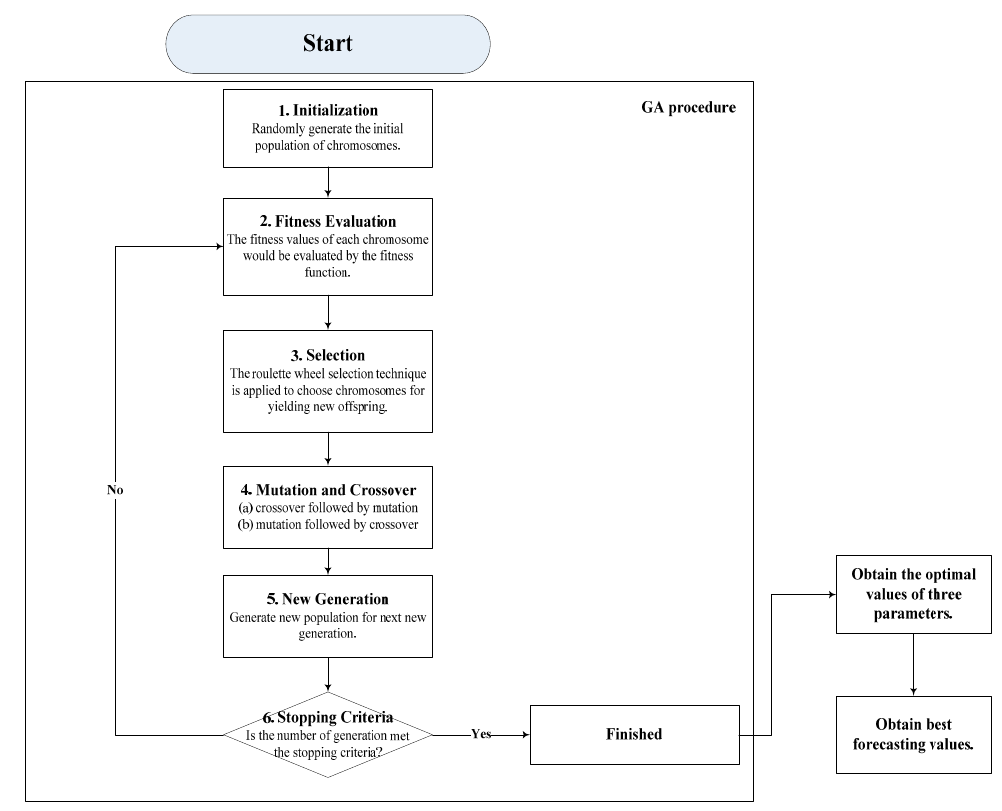
Figure 2. SVR- genetic algorithm (GA) algorithm flowchart.